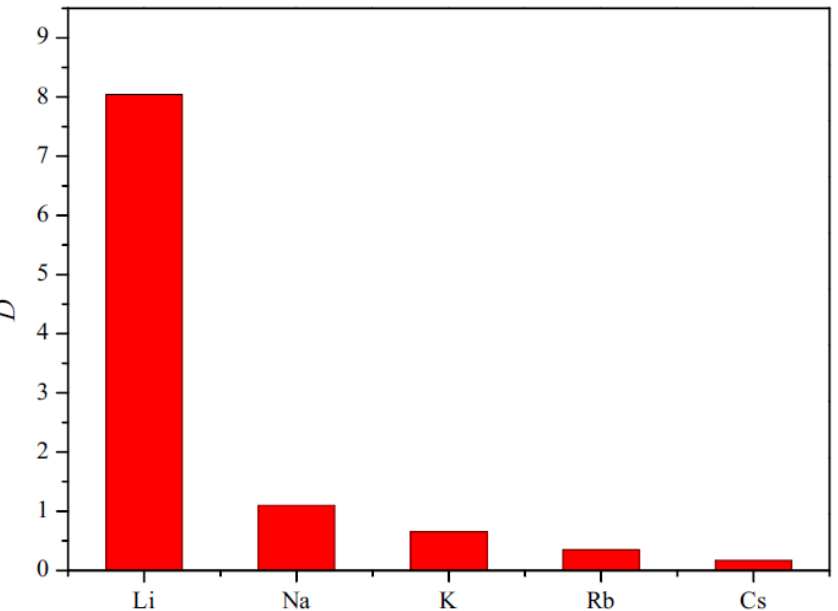
Figure 19. Selection of lithium over other alkali metal ions using an ionic liquid as the extractant and dichloromethane as the solvent [219]. The concentration factor “D” shows selectivity for lithium. Reprinted from Journal of Molecular Liquids, v. 304, Shi et al., Solvent extraction of lithium from aqueous solution using an ammonium ionic liquid, 112756, Copyright 2020, with permission from Elsevier.